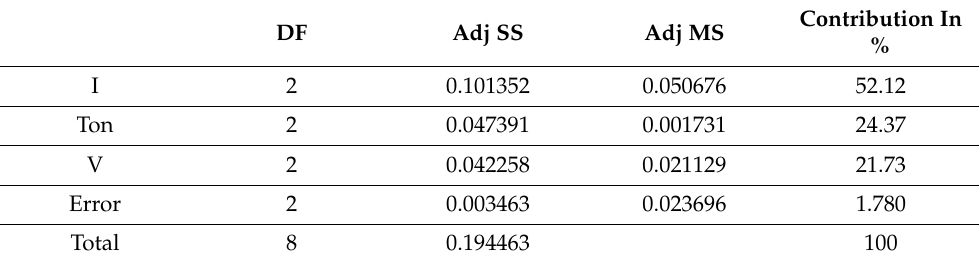
Table 9. Analysis of variance for sample